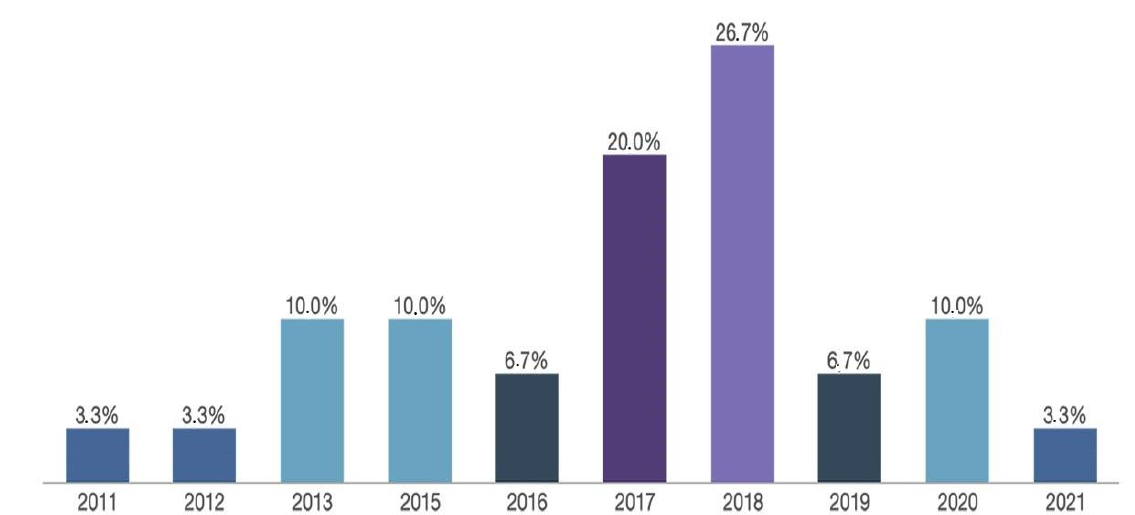
Figure 2. Progression among Publications Selected (2011 to 2021); Source: Compiled by author.